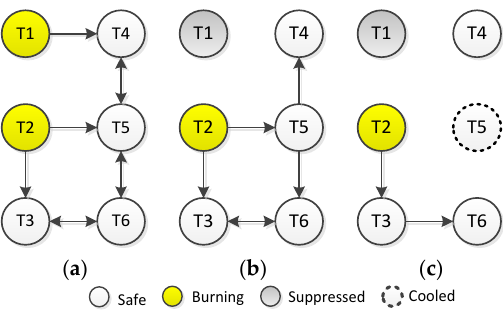
Figure 3. Non-optimal firefighting strategy for Scenario 1. ( a ) T1 and T2 are on fire. ( b ) T1 is suppressed while T2 is on fire. ( c ) T1 is suppressed, T2 is on fire, and T5 is cooled.